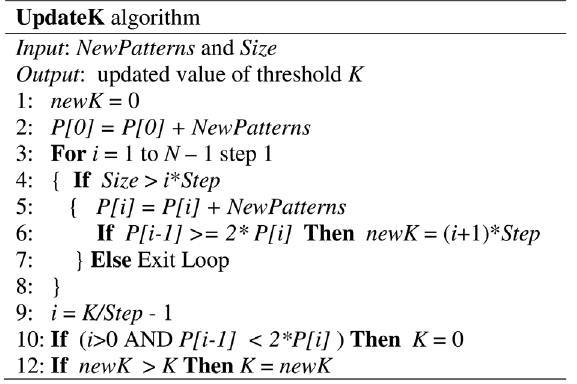
Figure 9. UpdateK